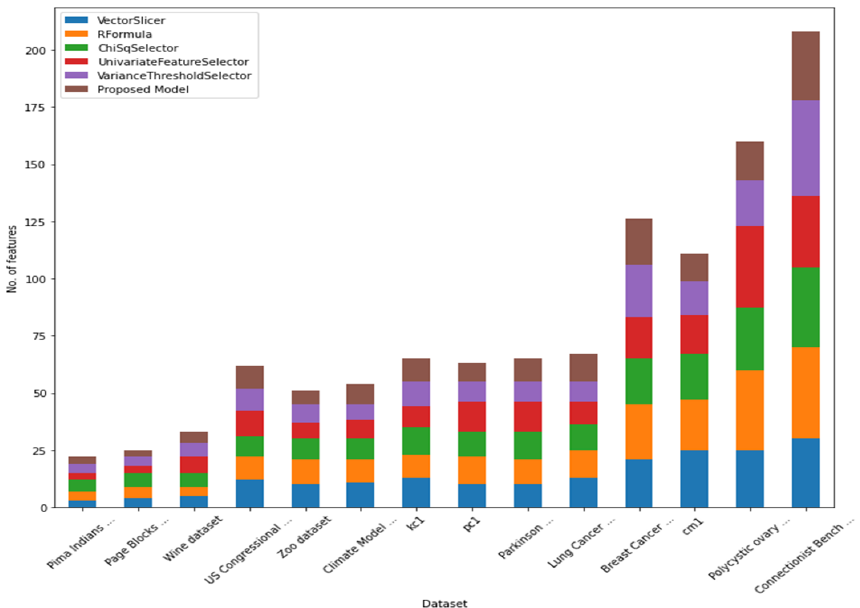
Figure 5. Comparison of performance of different feature selection algorithms with proposed model on the basis of number of features selected. Table 3. Classification accuracies obtained for different classification